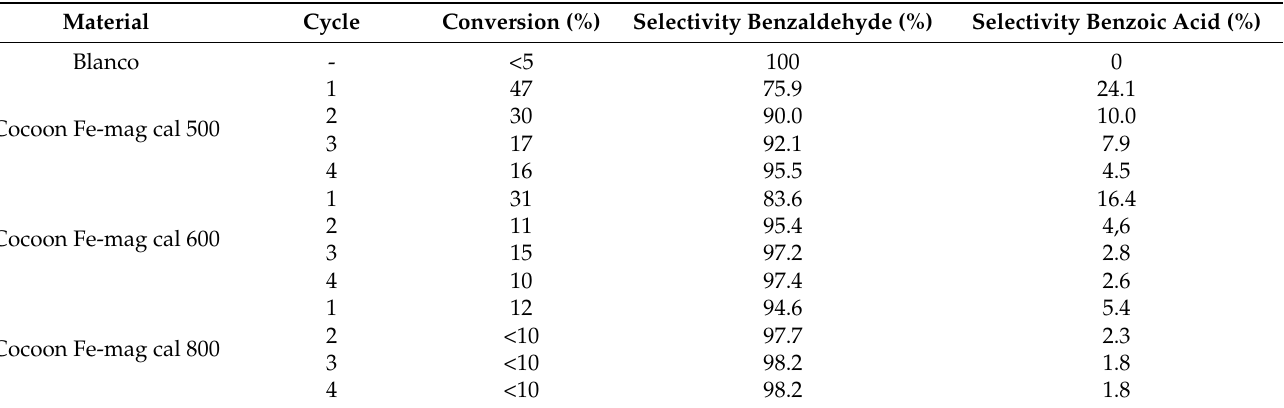
Table 2. Benzyl alcohol oxidation using 50 mg of catalyst, 2 mL of acetonitrile, 0.2 mL of